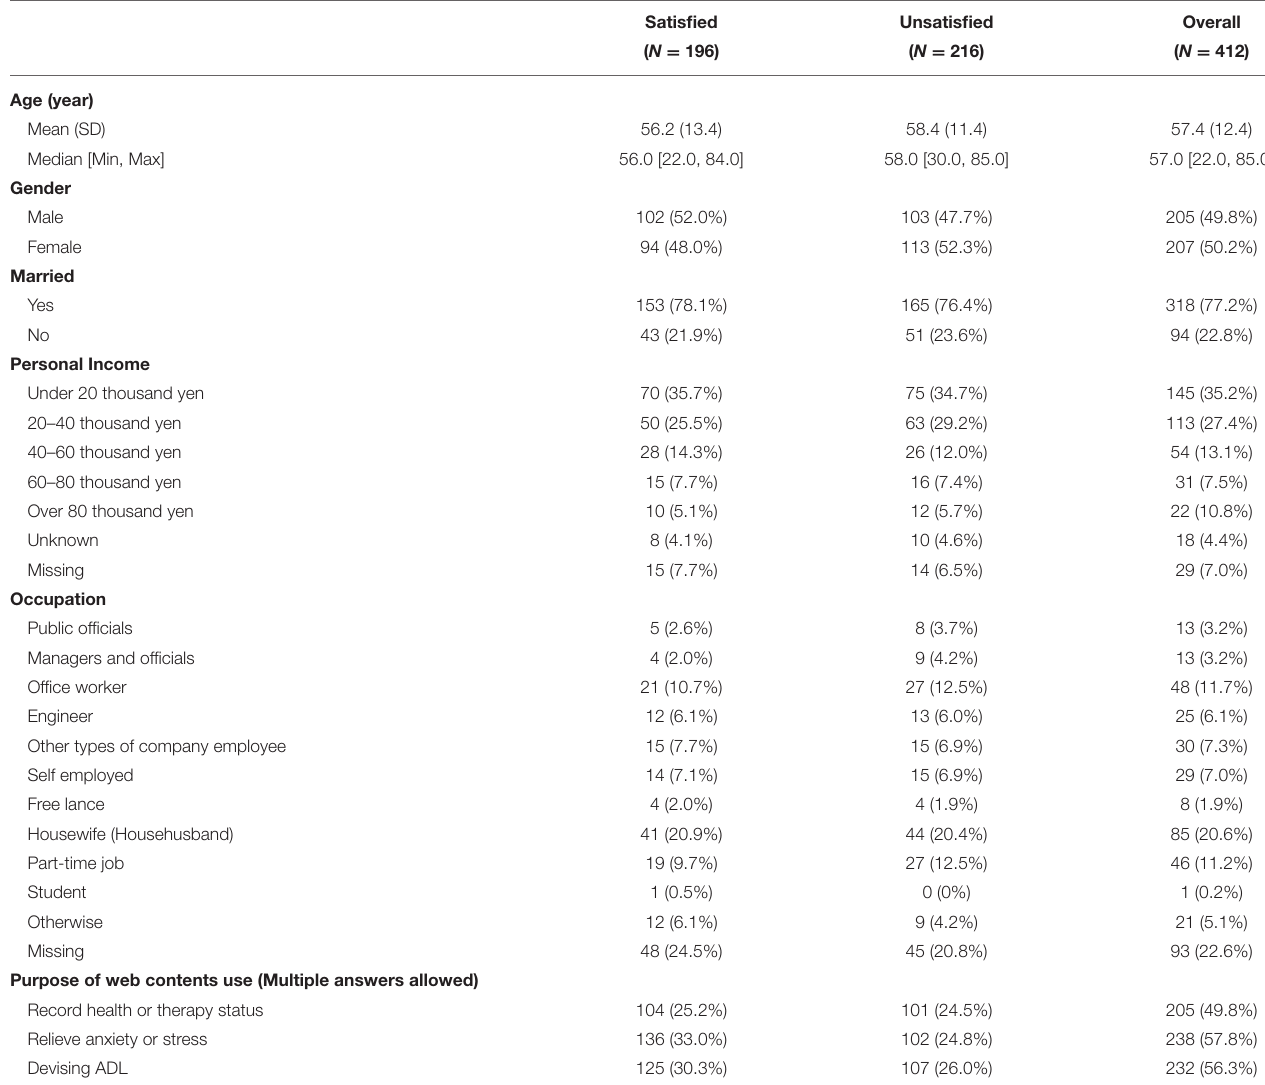
TABLE 1 | Demographics and epidemiological characteristics (N =